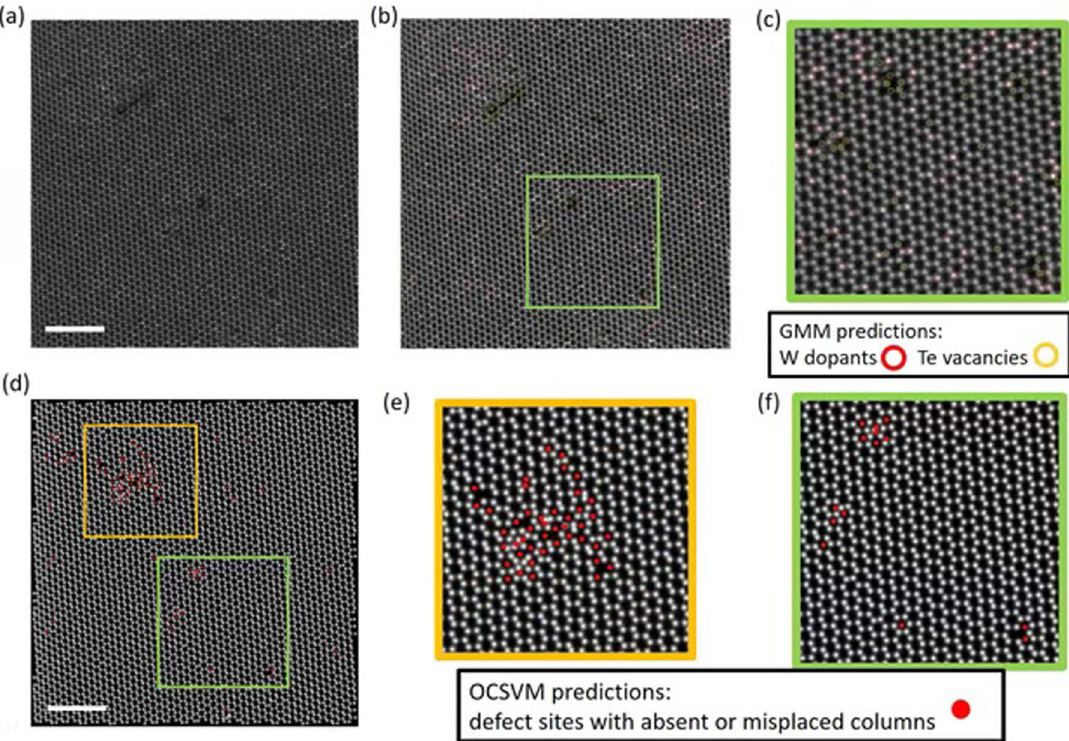
Fig. 1 Results of defect detection in bilayer Mo 0.91 W 0.09 Te 2 . a An ADF-STEM image acquired at 100 kV. b, c Classi fi cation of atom columns by applying GMM to integrated intensities of all atom columns. W dopants and Te vacancies (1 or 2 Te atoms missing) are labeled on top of the Gaussian-smoothed image of a . d Image of atomic coordinates derived from b . e, f Detection of defect sites with absent or displaced atom columns by applying OCSVM to d . Red dots indicate centers of segments that are predicted to be outliers. f shares the same region as c . The scale bars represent 3 nm. Panels a and d are adapted with permission from ref. 38 , © 2021 The